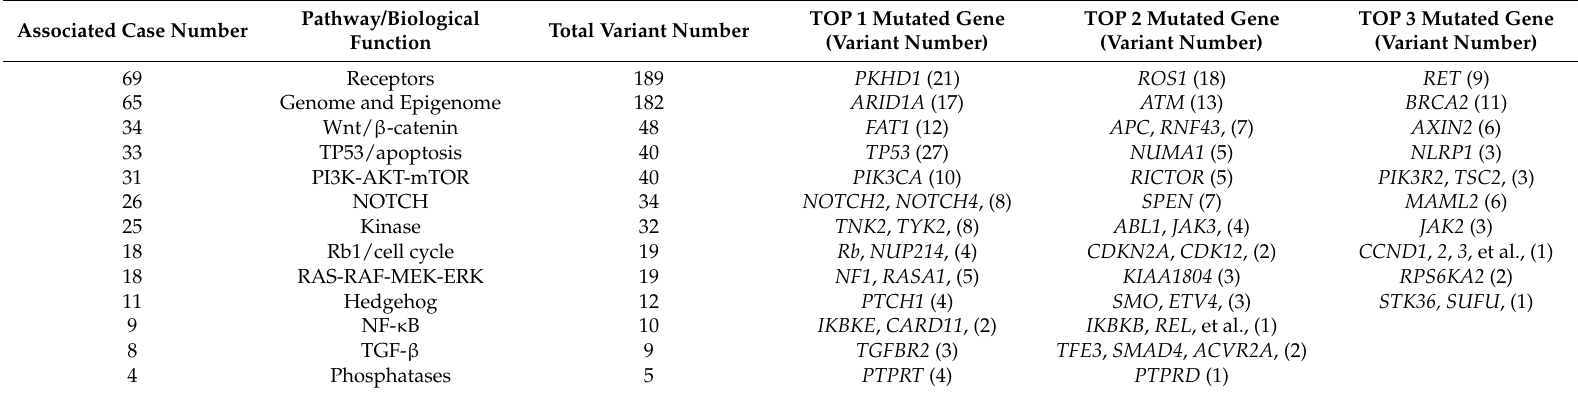
Table 3. Mutated Pathways Associated with Activated Mutant